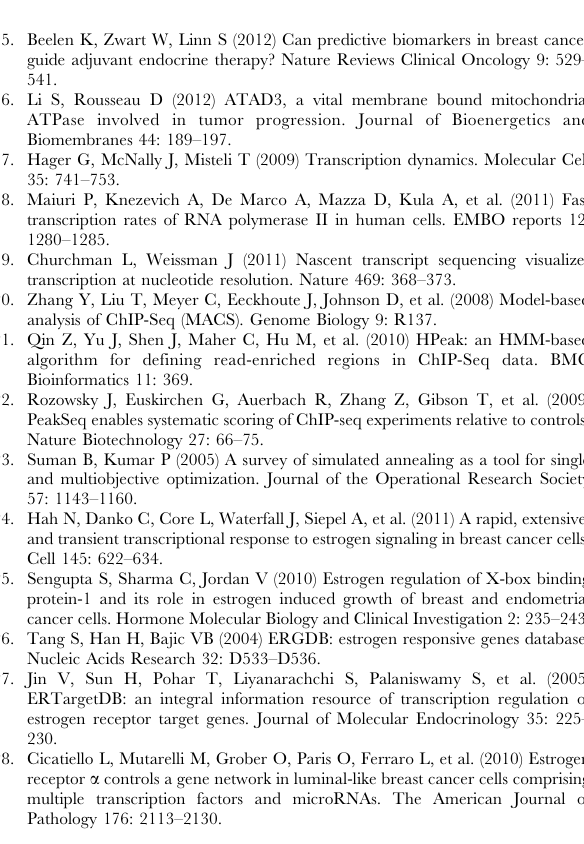
expression ( 2 1) of PMP22 . Expression groups with less than 20 patients are omitted. Vertical ticks represent censoring events. The X and Y axes represent follow-up time in months and the percentage of survival, respectively. The associated log-rank p-value is 6.4615e-03. Figure S20 PolII elongation speed lower bound estimates compared to gene lengths. The gene set includes induced and repressed estradiol early response genes. Genes are colored accoring to the time point by which the leading or lagging end reaches the 3 9 end; 80 minute time point includes genes for which the transition remains incomplete. For gene length, transcribed region lengths are used when this estimate is available; otherwise, lengths obtained from Ensembl are used. Figure S21 Short read counts of CCND1 in the GRO-seq experiments of [24], based on the Wiggle files in that publication. The screenshot is taken using IGV [38]. Figure S22 Short read counts of XBP1 in the GRO-seq experiments of [24], based on the Wiggle files in that publication. The screenshot is taken using IGV [38]. Figure S23 Venn diagrams for ER responsive gene set intersec- tions. Each number denotes the number of genes in the intersection. Data for the three external gene sets are from ERGDB [26], ERTargetDB [27] and Cicatiello et al. [28] (denoted Cic10; blue). Figure S24 Kaplan-Meier survival plot comparing patients from [30] having above or below median expression of ATAD3B .